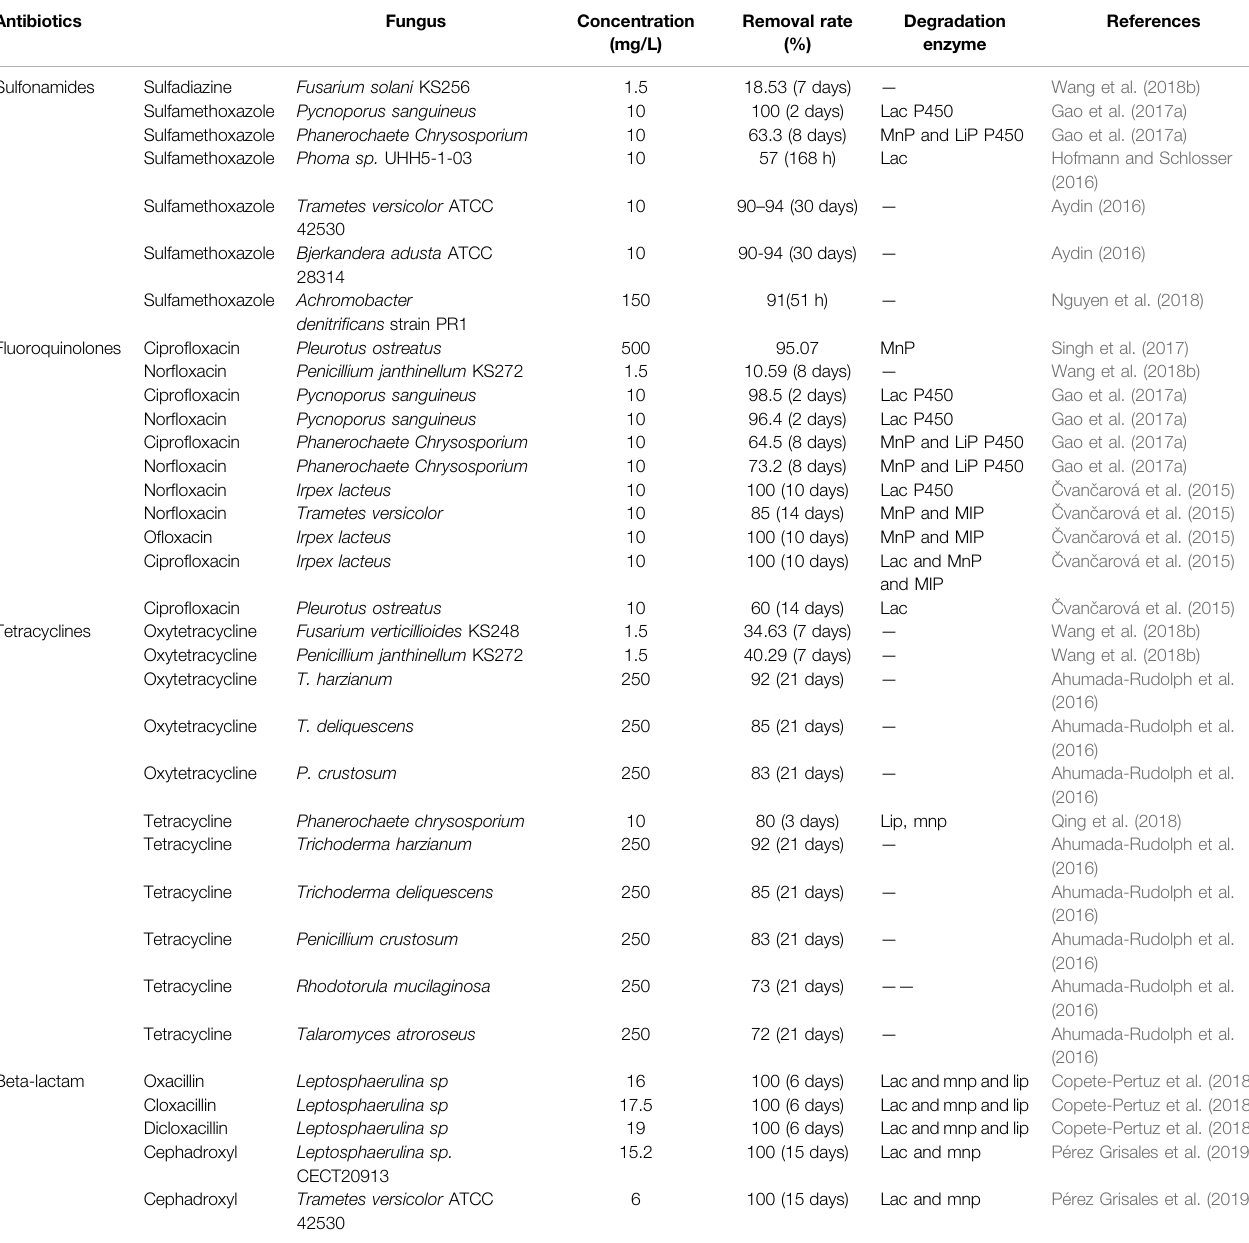
TABLE 9 | Antibiotic-degrading fungi reported in the recent 5